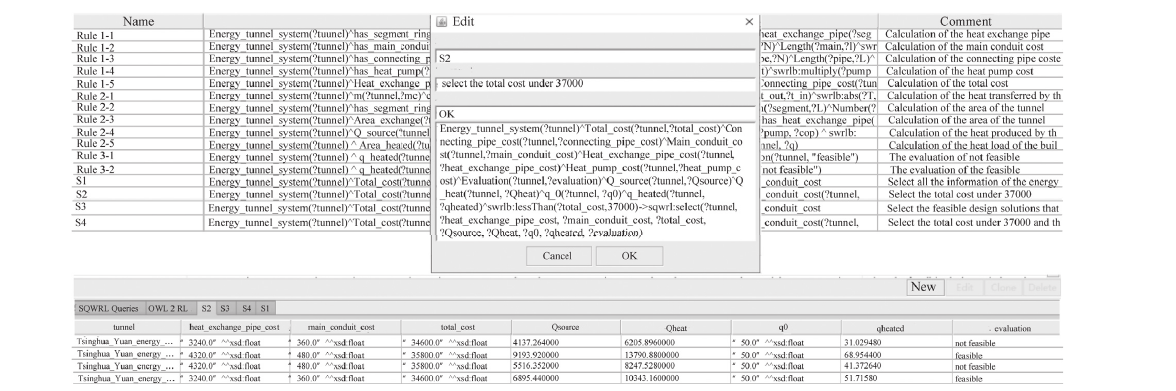
Figure 10: Execution and results of Table 8. Table 9: SQWRL rule for selecting design schemes with feasible heat flux.